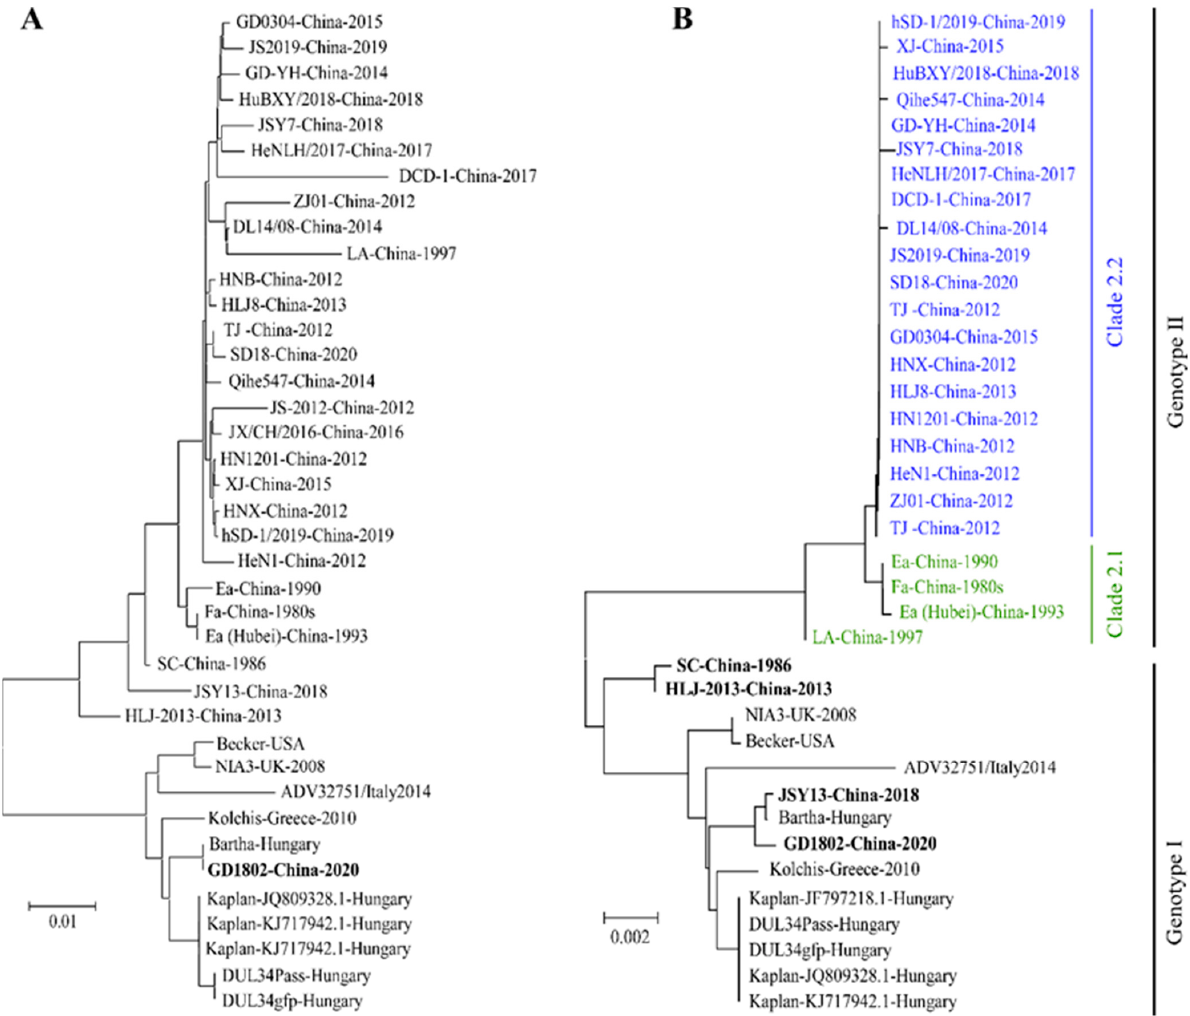
Figure 1. The phylogenetic analysis of PRV full-length genome sequences and gC sequences. ( A ) Phylogenetic analysis of PRV complete genome sequences. ( B ) Phylogenetic analysis of PRV gC gene sequences. Both maximum likelihood (ML) trees were constructed by using MEGA X software.